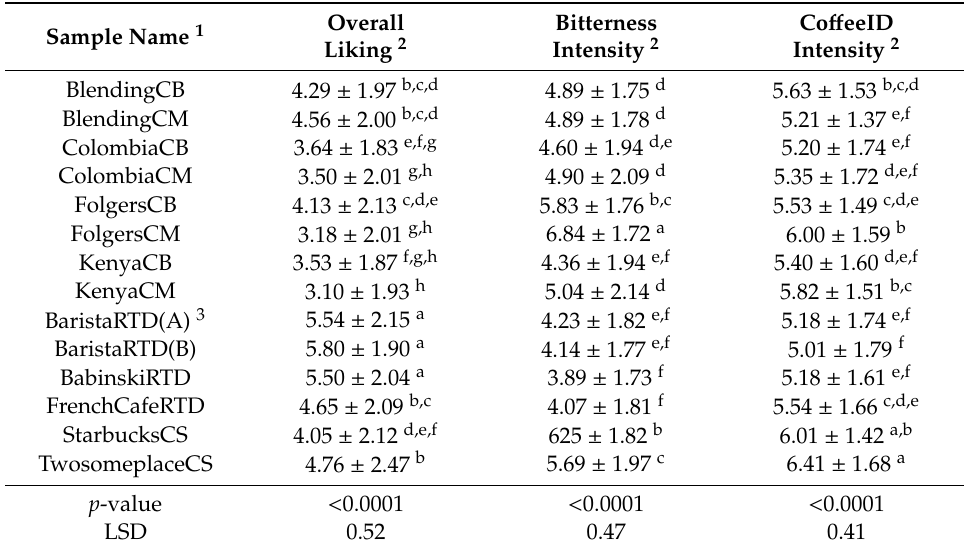
Table 8. Mean intensity of consumers’ overall liking, bitter intensity, and co ff eeID intensity of co ff ee